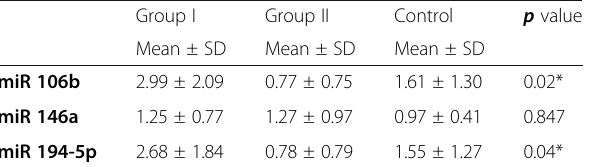
Table 2 Comparison between groups I and II and control subjects as regards the expression of miR 106b, miR 146a,